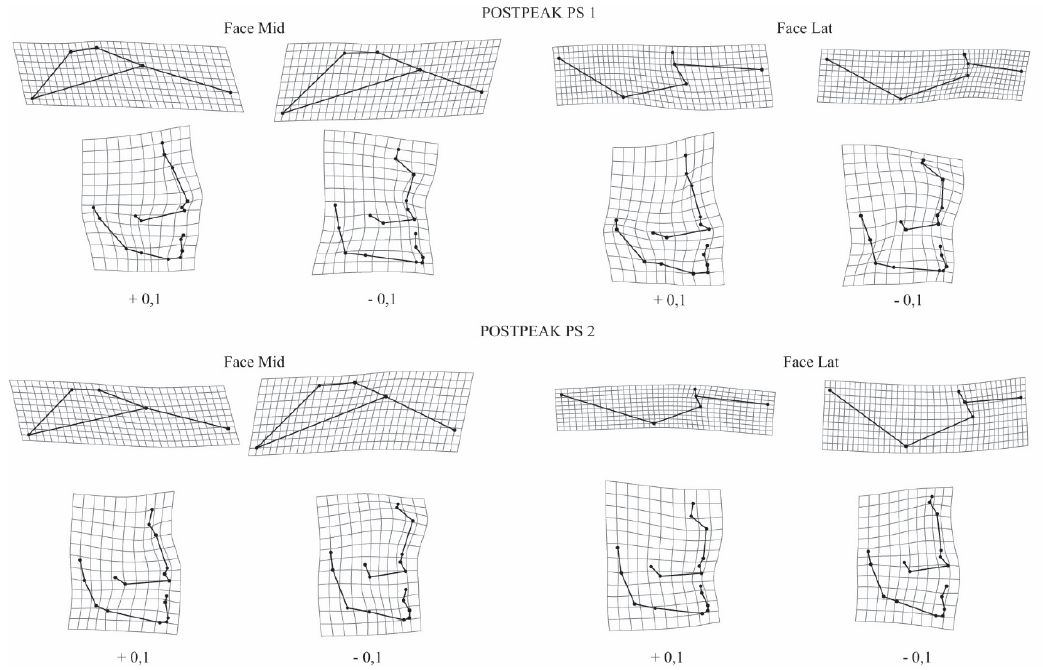
Figure 2. The figure shows Principal axes (PS) 1 and 2 for all groups.